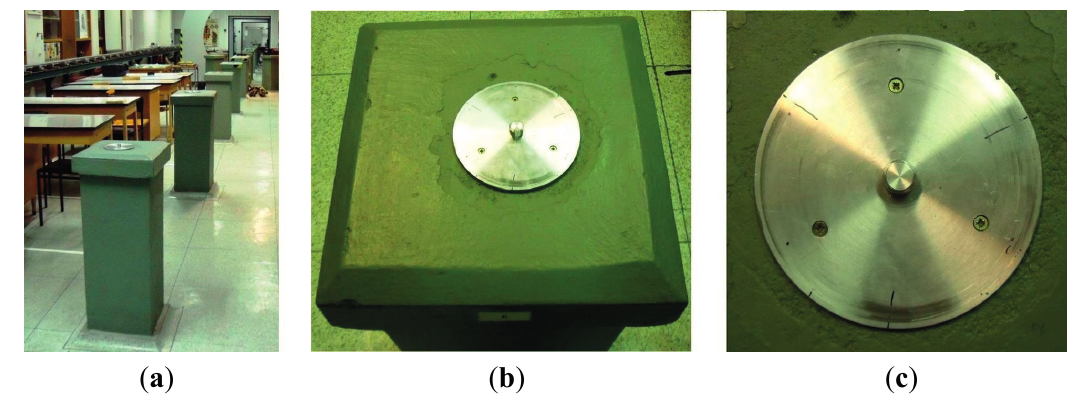
Figure 3. Schematic of the laboratory baseline.